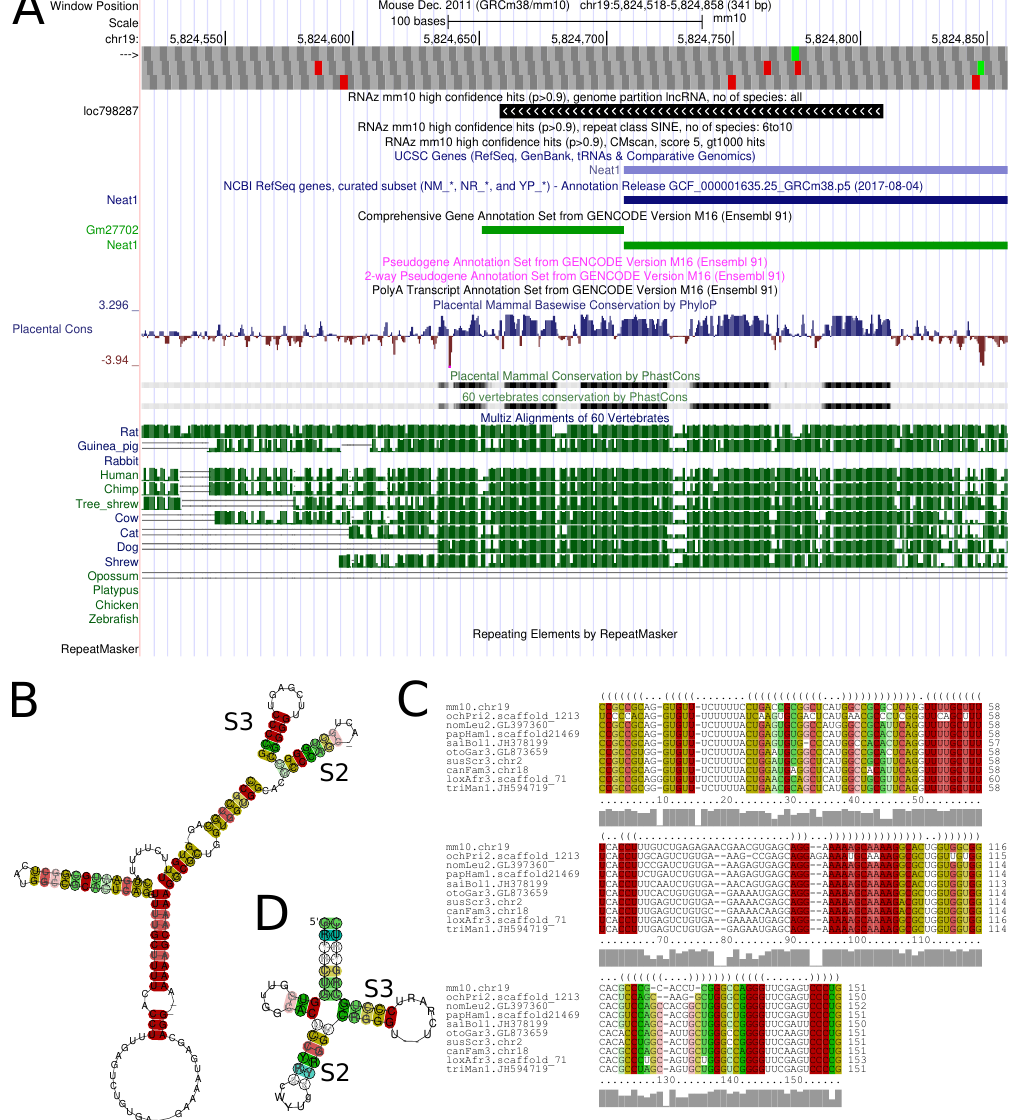
Figure 6. The lncRNA Neat1 contains a conserved structure element (loc798287) that has some similarity to MALAT1-associated small cytoplasmic RNA (mascRNA, RF01684). We identified a conserved structure element that goes beyond the known mascRNA structure. However, we identified two substructures of mascRNA, stem 2 (S2, panel B and D) and stem3 (S3, panel B and D). ( A ) Browser image of Neat1 5’ end; ( B ) Secondary structure plot of loc798287; ( C ) Corresponding alignment with color-coded conservation patterns; ( D ) Consensus structure of mascRNA